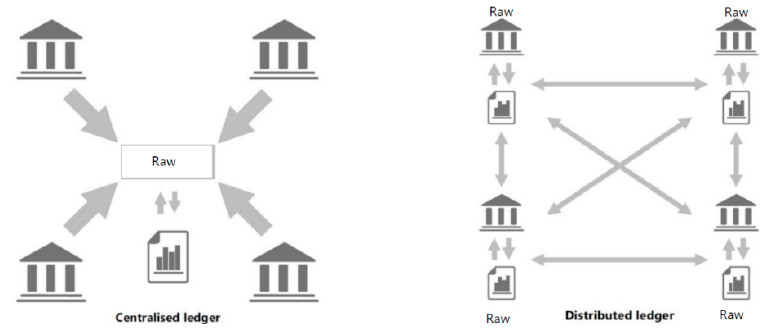
Figure 2. Blockchain architecture for raw data.